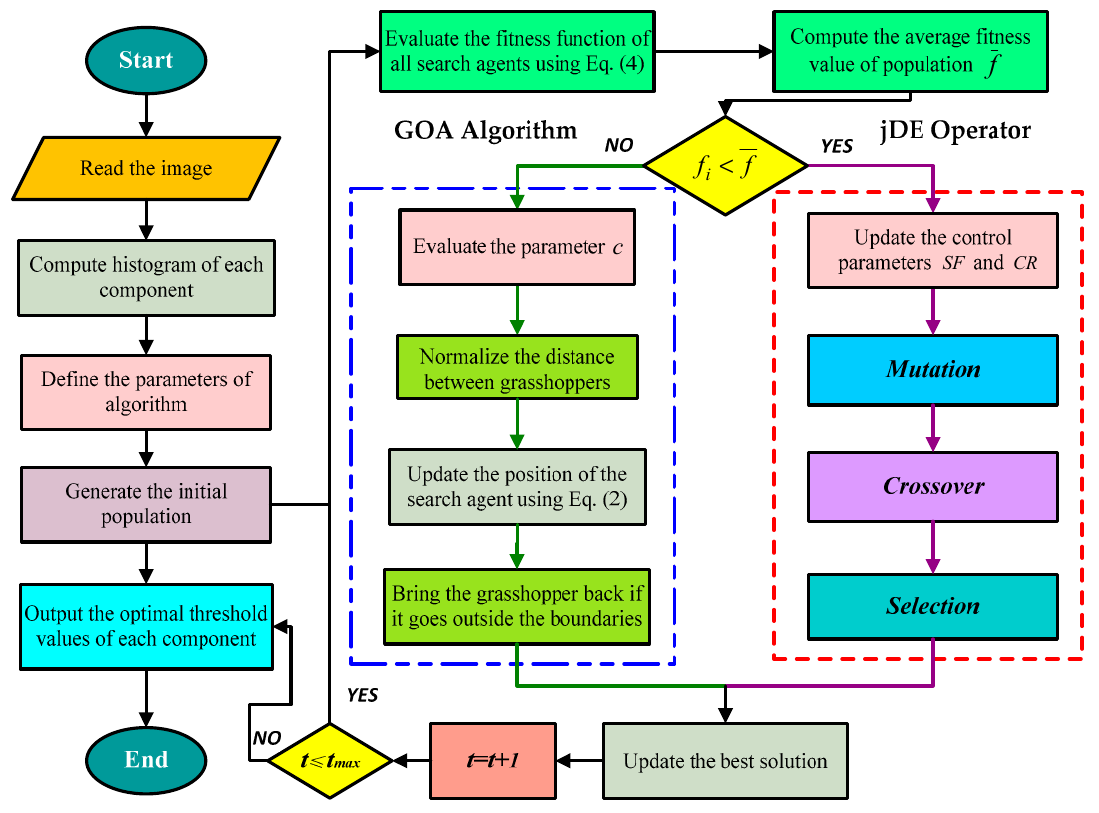
Figure 3. Framework of the GOA–jDE-based method.